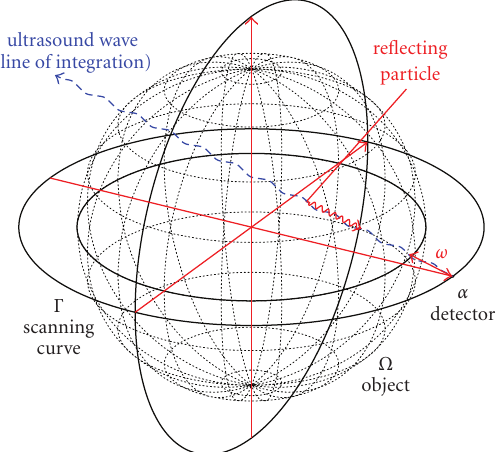
Figure 16: Measurement setup using two orthogonal circles as scanning curve Γ , one in the plane { x 3 = 0 } as usual, and one in the plane { x 1 = 0 }